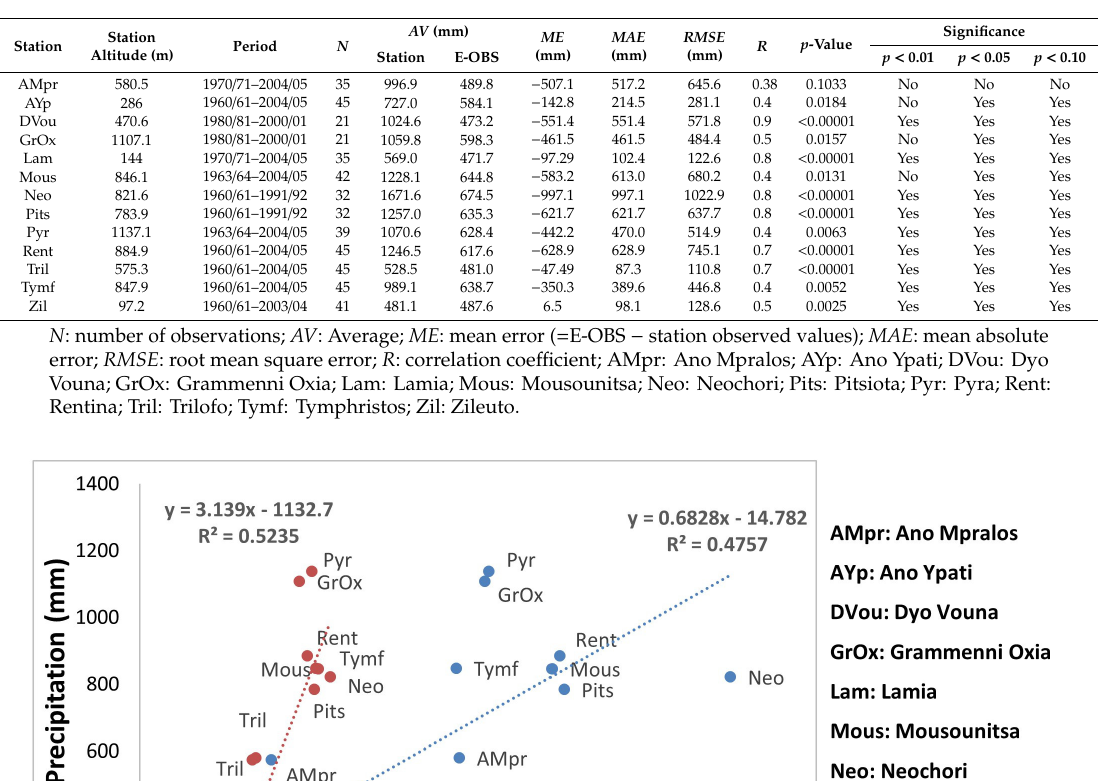
Table 5. Statistical characteristics and e ffi cient criteria of annual observed precipitation measurements and E-OBS dataset.